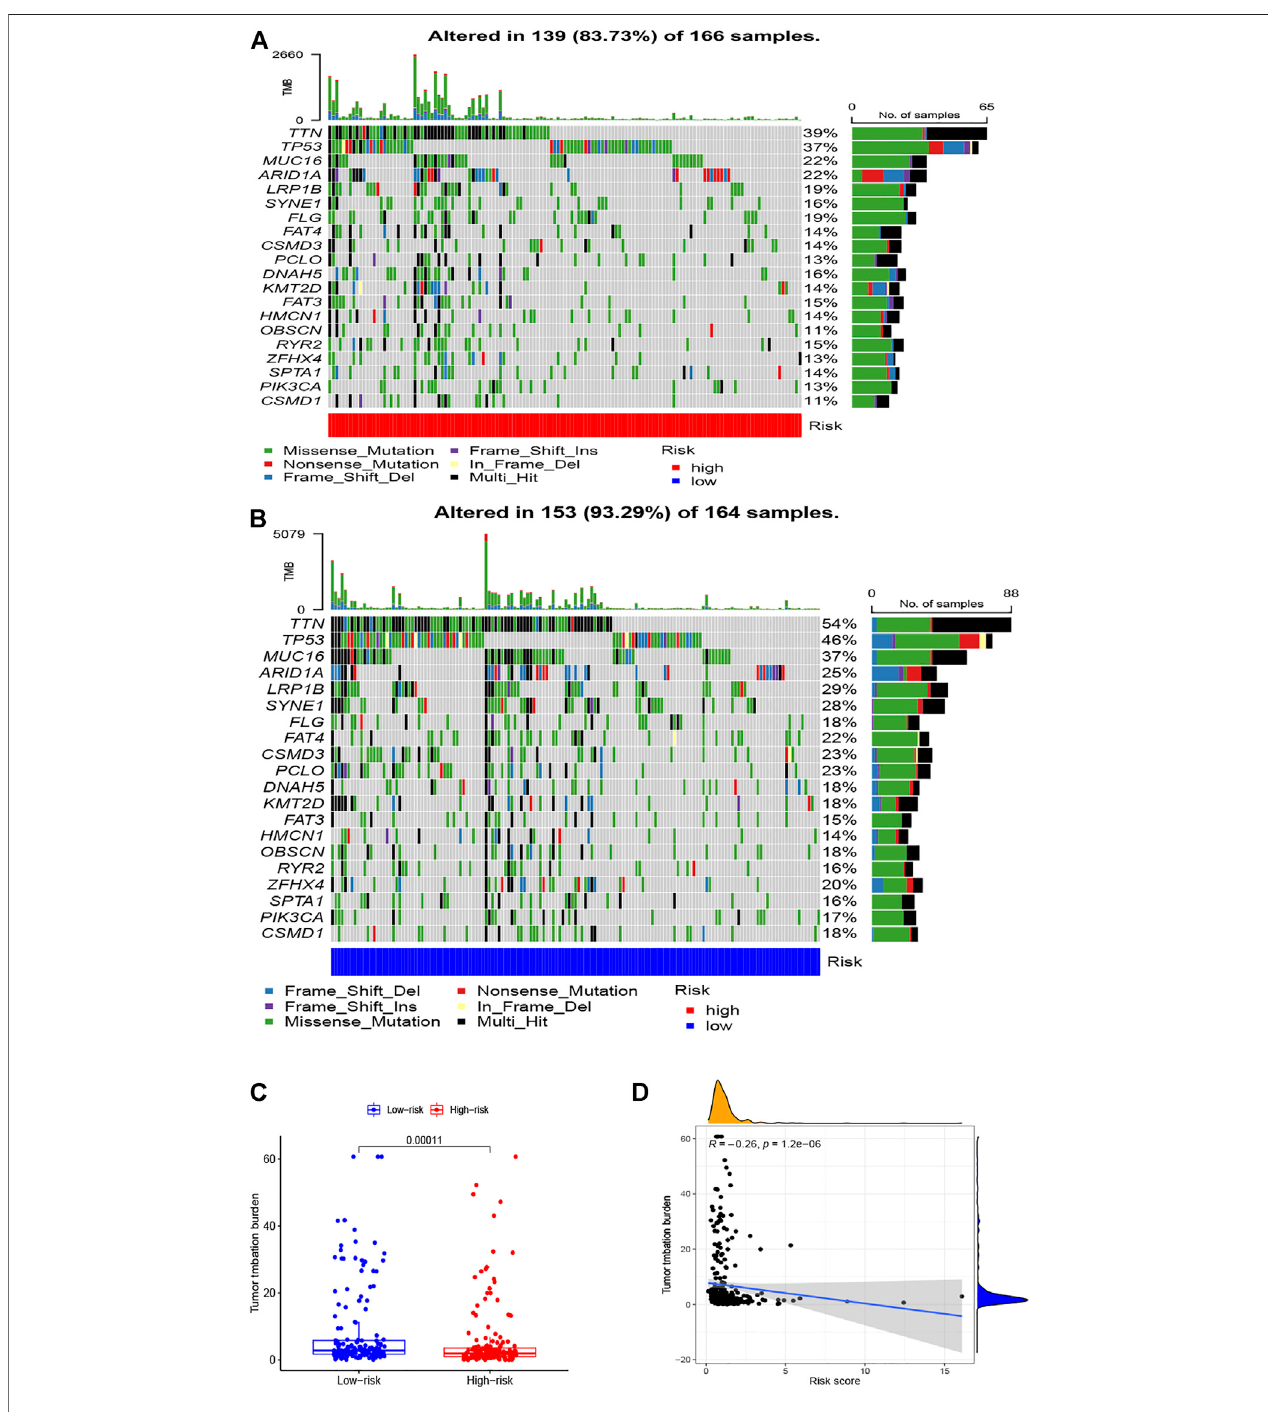
FIGURE7| CorrelationsbetweenTMBandriskscores.OncoPrintdisplaysthemutationpro fi leofthetop20frequentlymutatedgenesin (A) high-and (B) low-risk patients. (C) Boxplot shows the difference in TMB between high- and low-risk patients. (D) The correlation analysis between TMB and risk scores.